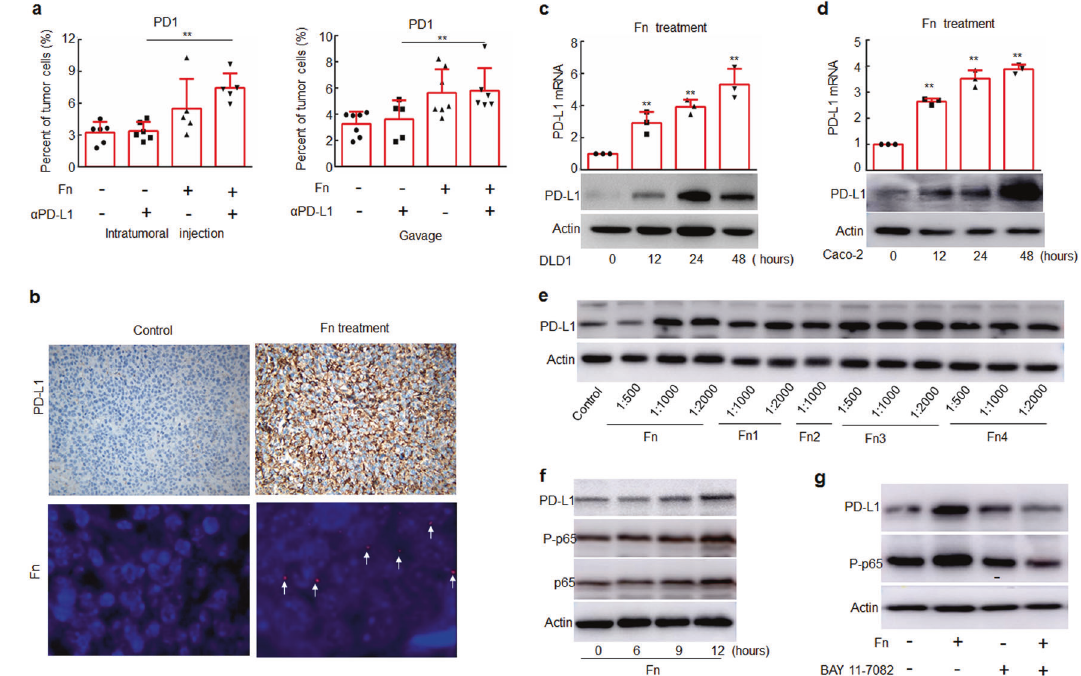
Fig. 4 F. nucleatum induces the expression of PD-1 and PD-L1. a Flow cytometry was used to detect the expression of PD-1 in tumor tissues from mice treated with F. nucleatum and/or an anti-PD-L1 mAb. One-way ANOVA and Bonferroni ’ s multiple comparison test. b The protein levels of PD-L1 were detected by IHC, and F. nucleatum was detected by FISH in tumor tissue samples from mice. Brown staining in IHC and red staining in FISH (white arrows) indicate positive staining. c , d DLD1 and Caco-2 cells were treated with Fn (1:1000) for different time course, and the mRNA and protein levels of PD-L1 were detected by RT-PCR and Western blotting, respectively. Student ’ s t -test. e DLD1 cells were treated with different dilutions of different Fn isolates obtained from CRC patients. f DLD1 cells were treated with Fn (1:1000) for different time course. g DLD1 cells were treated with Fn (1:1000) and/or 5 μ M BAY 11 – 7082 for 24 h. The expression of the indicated proteins was detected by Western blotting. Actin was used as a loading control. Bars represent s.d. of at least three experiments. * P < 0.05; ** P < 0.01. Fn, F. nucleatum . NS, no signi fi cant